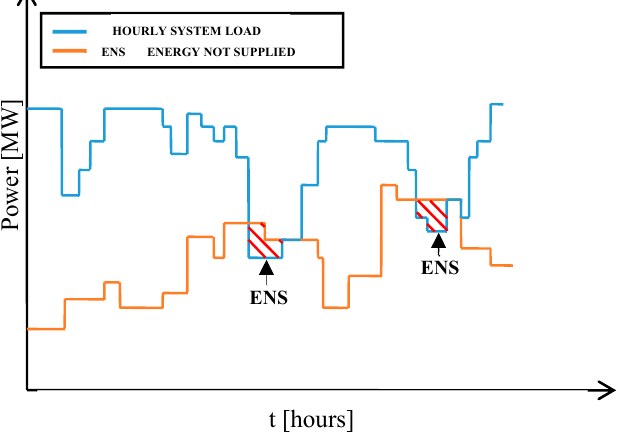
Figure 6. Energy not supplied for a HVDC system as a function of the electrical load variation.